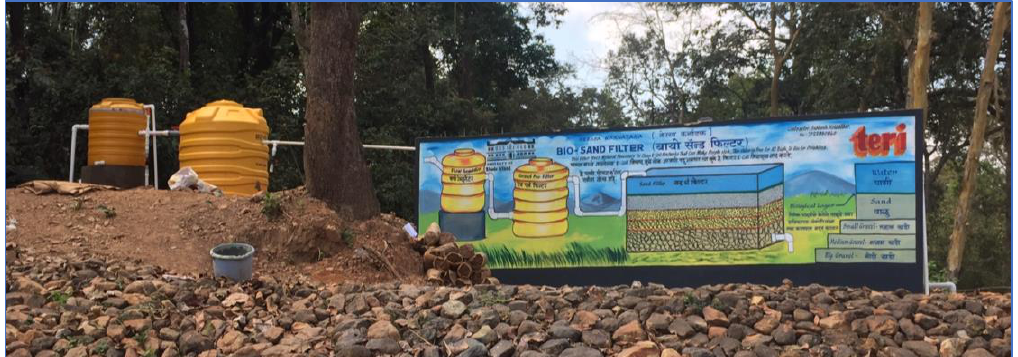
Figure 3. Picture of the IBF filter system. A diagram was painted on the filter wall giving a simple explanation of the system in both English and Marathi, the local language.